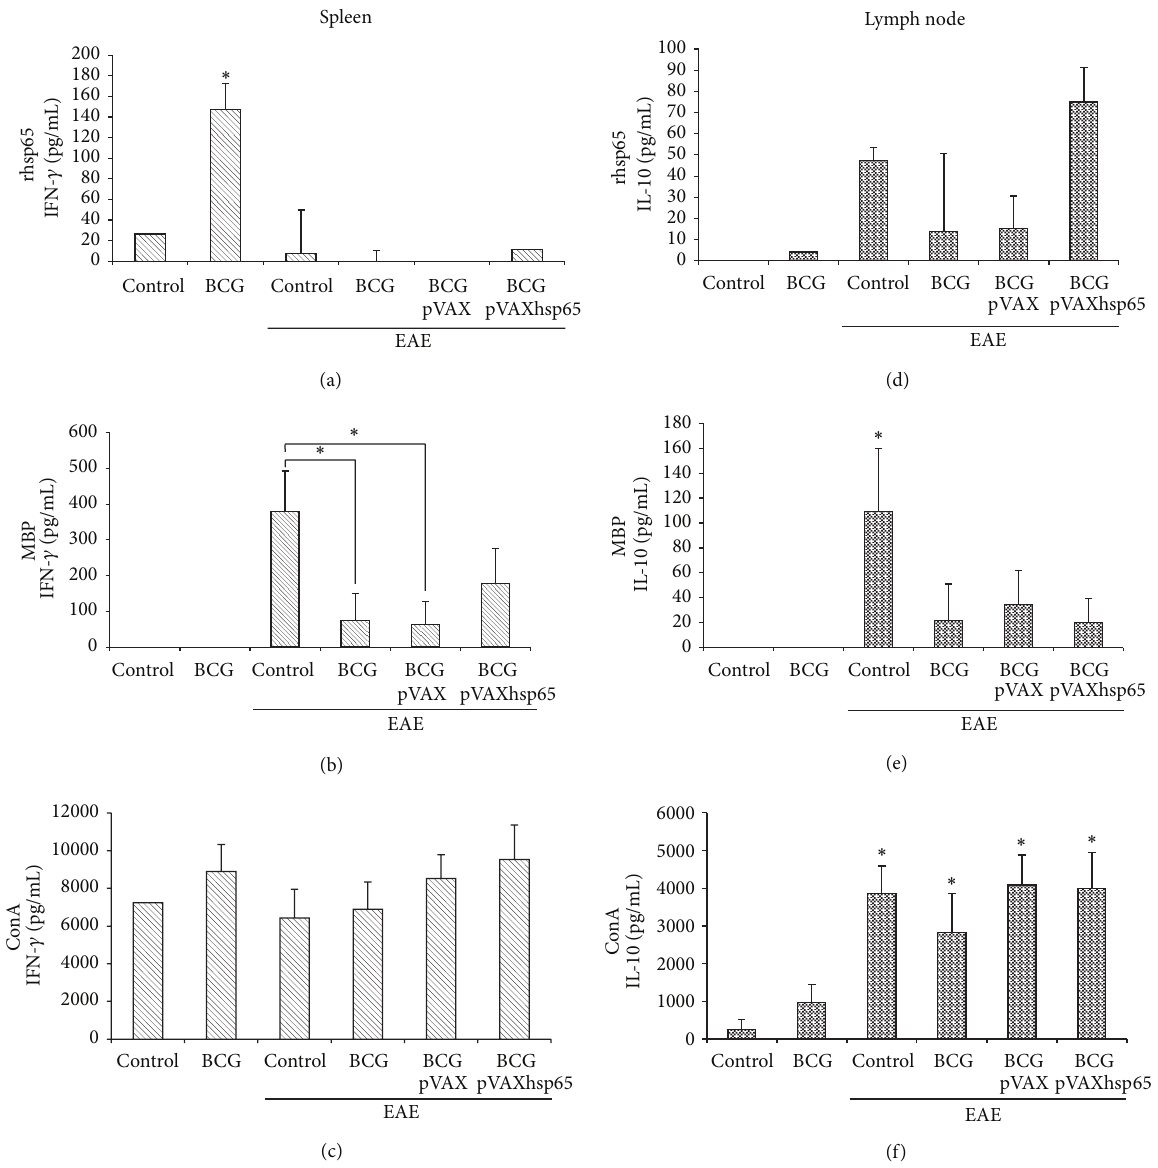
Figure 4: Effect of tuberculosis vaccines in IFN- 𝛾 and IL-10 production. Female Lewis rats were immunized with BCG alone or with BCG followed by pVAXhsp65 boosters and then underwent EAE induction by inoculation of MBP emulsified with CFA. Animals were euthanized during the recovery phase (20th day after MBP inoculation) and spleen and lymph node cell cultures were stimulated with rhsp65 ((a) and (d)); MBP ((b) and (e)); and ConA ((c) and (f)). IFN- 𝛾 levels were evaluated in spleen cell cultures ((a), (b), and (c)) and IL-10 levels were evaluated in lymph node cell cultures ((d), (e), and (f)). Data are presented by mean ± SEM for 4–6 animals. ∗ Represents the difference between immunized and control groups. 𝑃 < 0.05